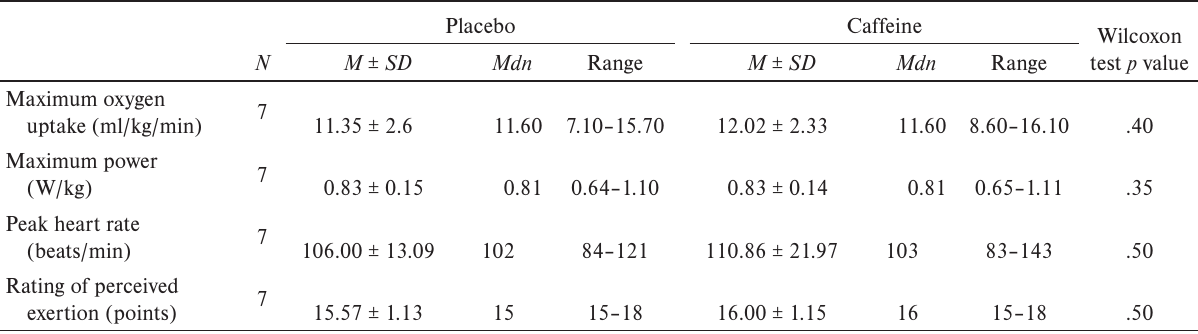
Effect of caffeine or placebo